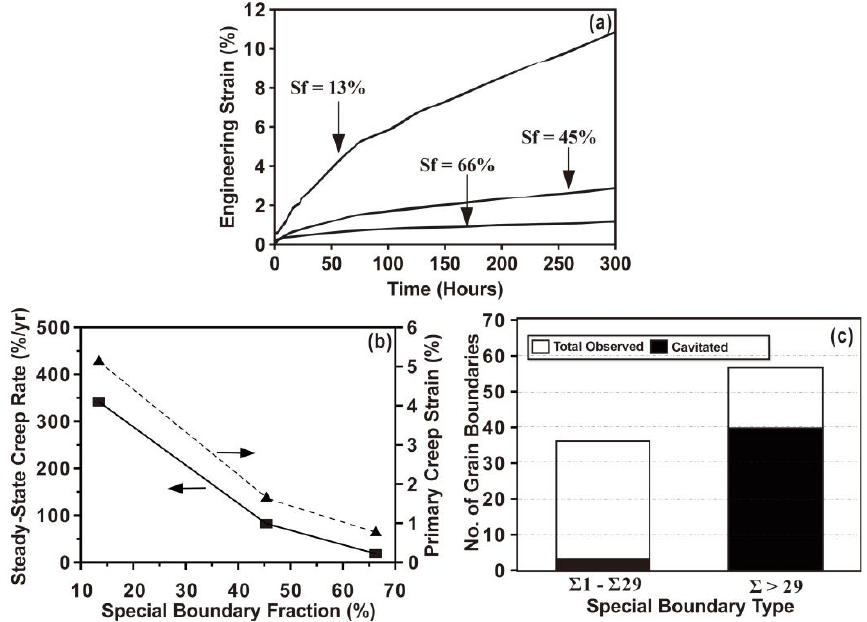
Figure 7. Influence of GBE on the creep properties of nickel. ( a ) Comparisons of creep curves for nickel samples with various fractions of special GBs (Sf); ( b ) Effect of the fraction of special GBs on the steady-state creep rate and total primary creep strain; ( c ) Relative proportion of RHAGBs ( Σ > 29) and special GBs ( Σ 1– Σ 29) showing cavitation in the sample with the Sf = 45. adopted from Ref. [72]